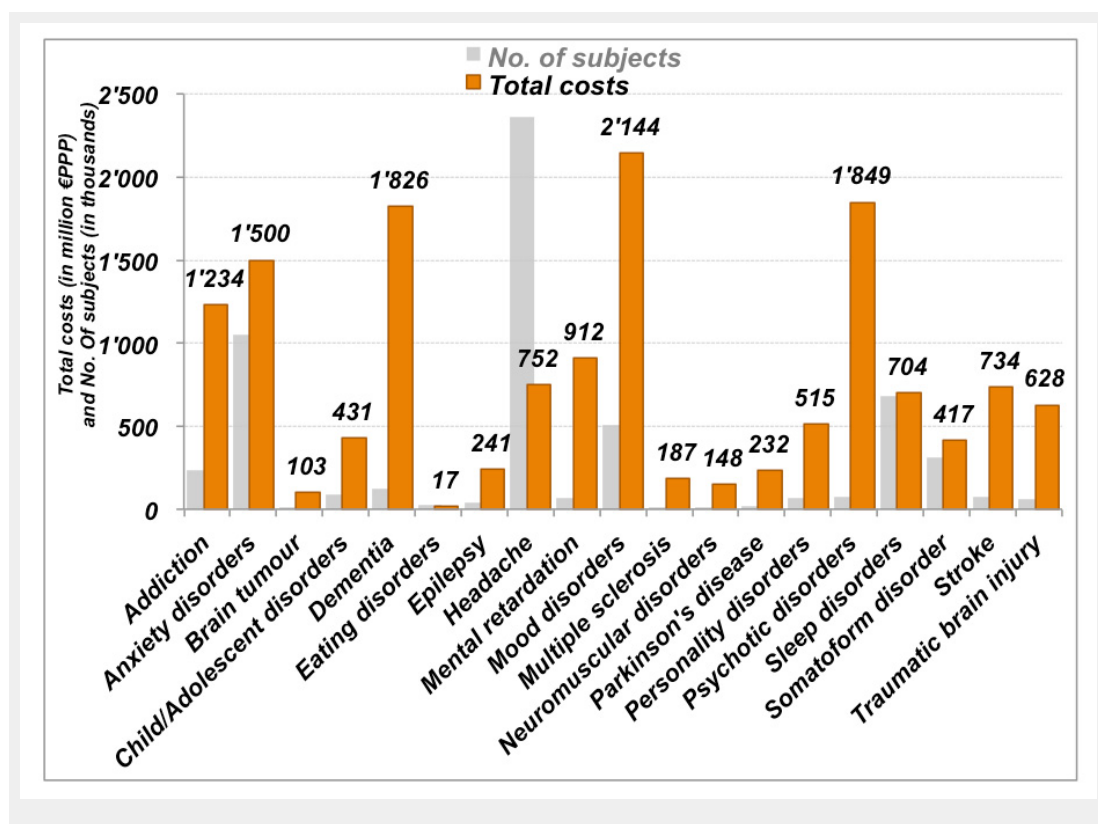
Figure 2 Total costs of specific disorders of the brain in